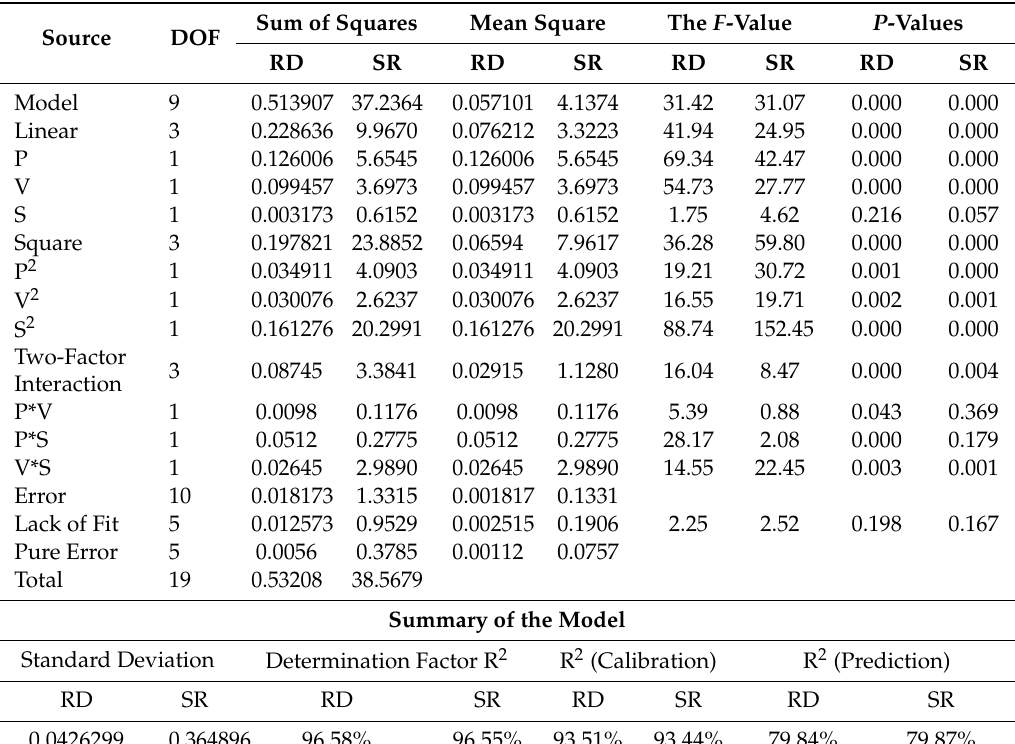
Table 4. Analysis of variance results for RD and